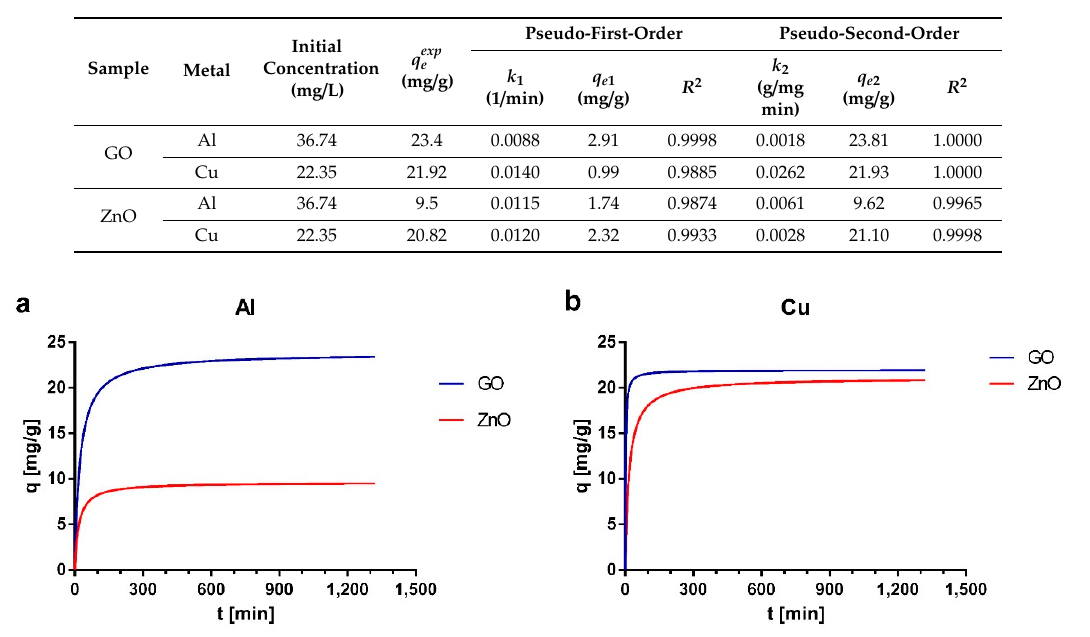
Figure 5. Kinetic curves for ( a ) Al and ( b ) Cu based on the pseudo-second-order model.